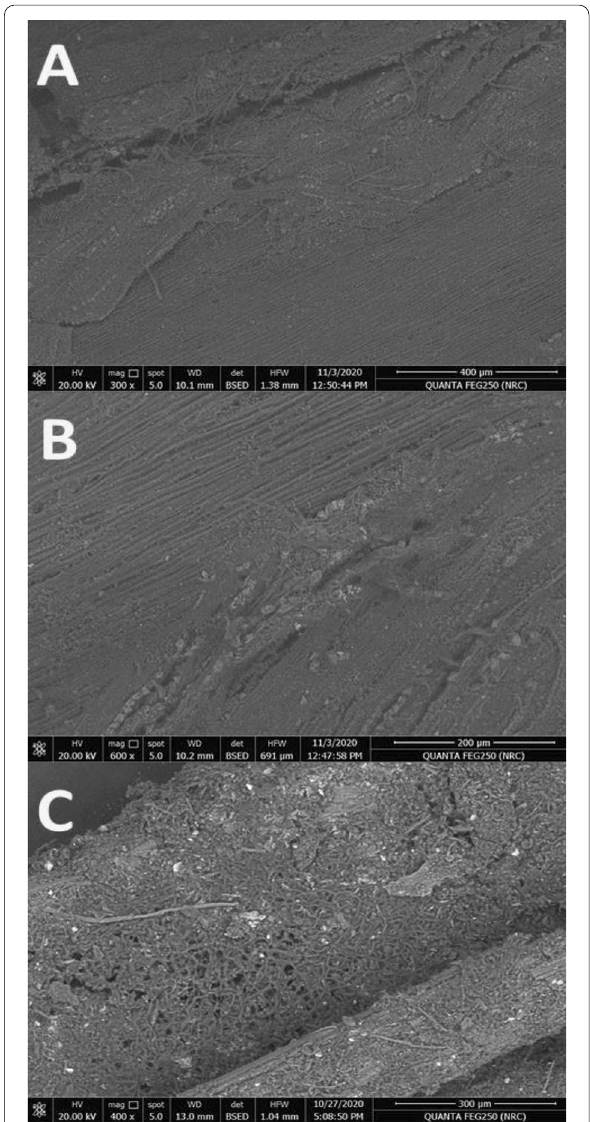
Fig. 2 Topography analysis of raw CTF ( A ), tCTF ( B ) and t CTF/COW ( C